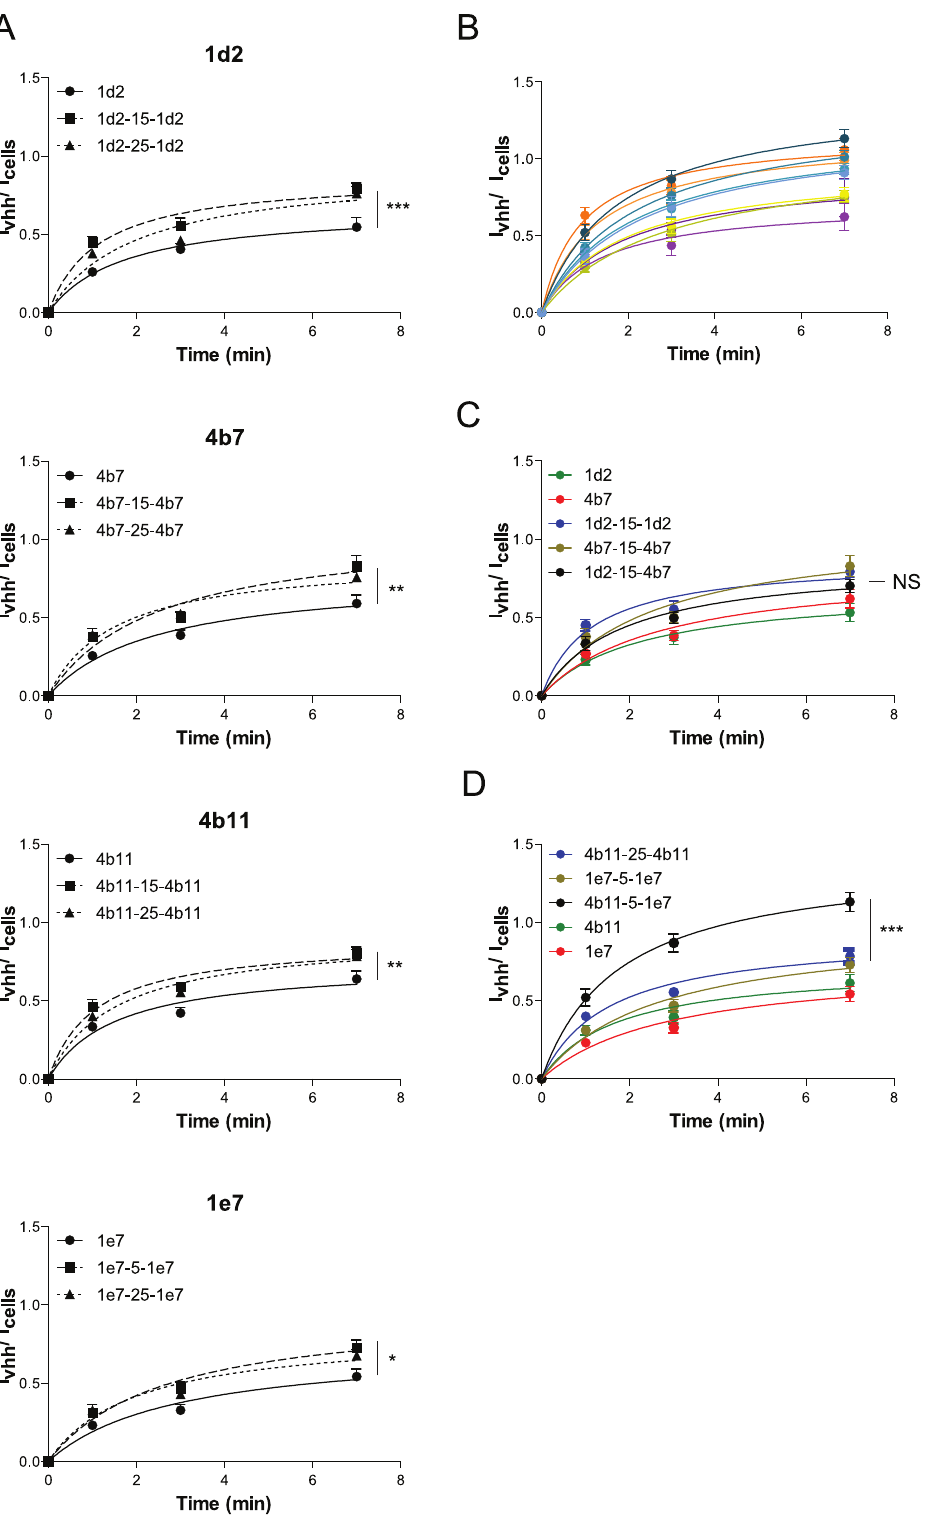
Figure 4. Bivalency enhances internalization. (A–D) Internalization assay of selected VHHs. 1 m M VHH was incubated on cells at 37 u C for 1, 3 or 7 min. Externally bound VHH was removed with 25 m g/ml trypsin for 45 min on ice. Internalized VHH was immunolabelled with an anti-myc tag and D- a -M-IR800 antibodies. Quantification of fluorescence is described in experimental procedures. Fluorescence intensities of the internalized amount is divided over the amount of cells (To-pro3 nuclear stain) and plotted against time. The signal of the irrelevant anti-hTfR VHH was deducted from the specific VHH signal and therefore represents the x-axis (n=12) (s.e.m.’s are shown for all points).